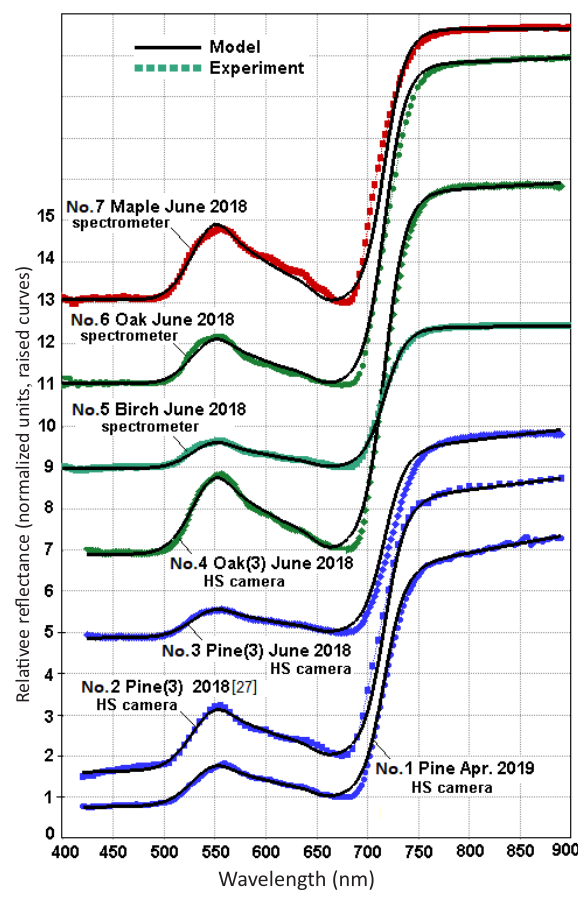
Fig. 8. Green vegetation reflectance compact model fitting results for seven experimental data sets from Table 2. Curves are presented in normalized units and raised up by different values for better readability. The four amplitude parameters are different for each data set and shown in Table 3. The nine wavelength­ related parameters use the common values shown in Table